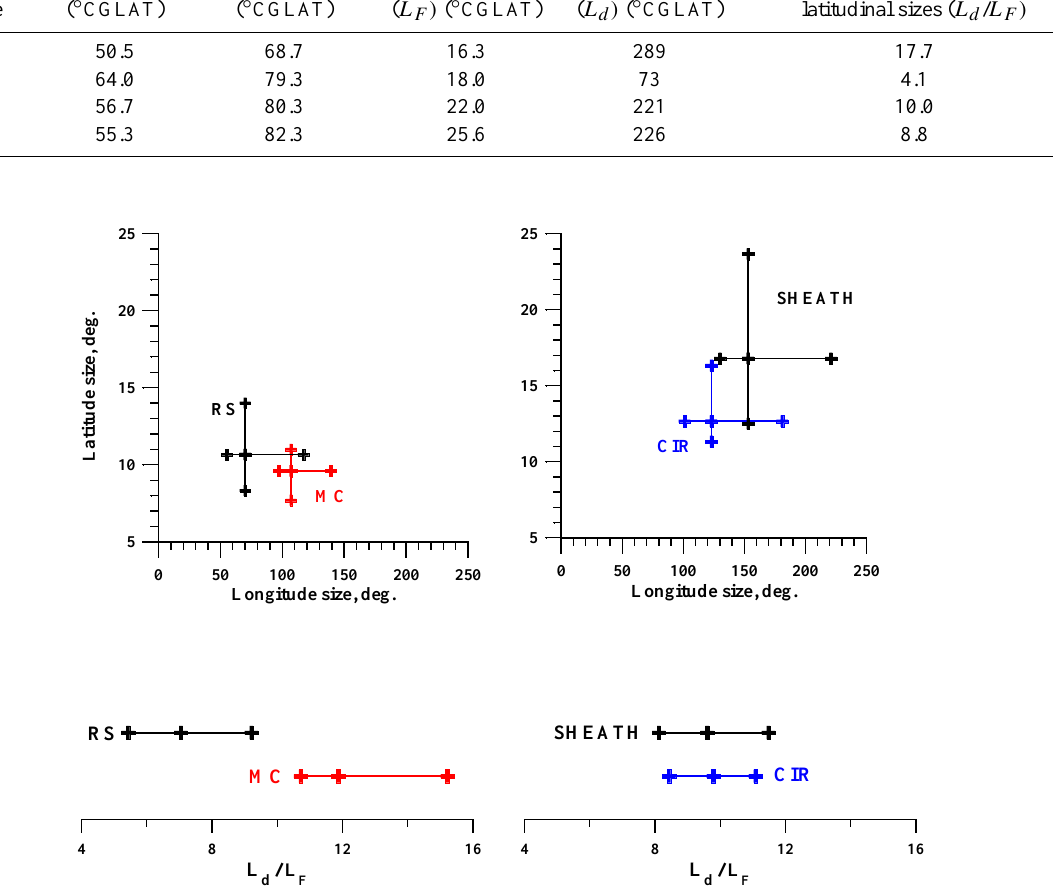
Table 1. Latitudes and sizes of the auroral bulge and ratio between bulge sizes for four solar wind structures (MC, RS, Sheath and CIR). Solar wind Onset latitude Maximal latitude Latitudinal size Longitudinal size The ratio between longitudinal and structure